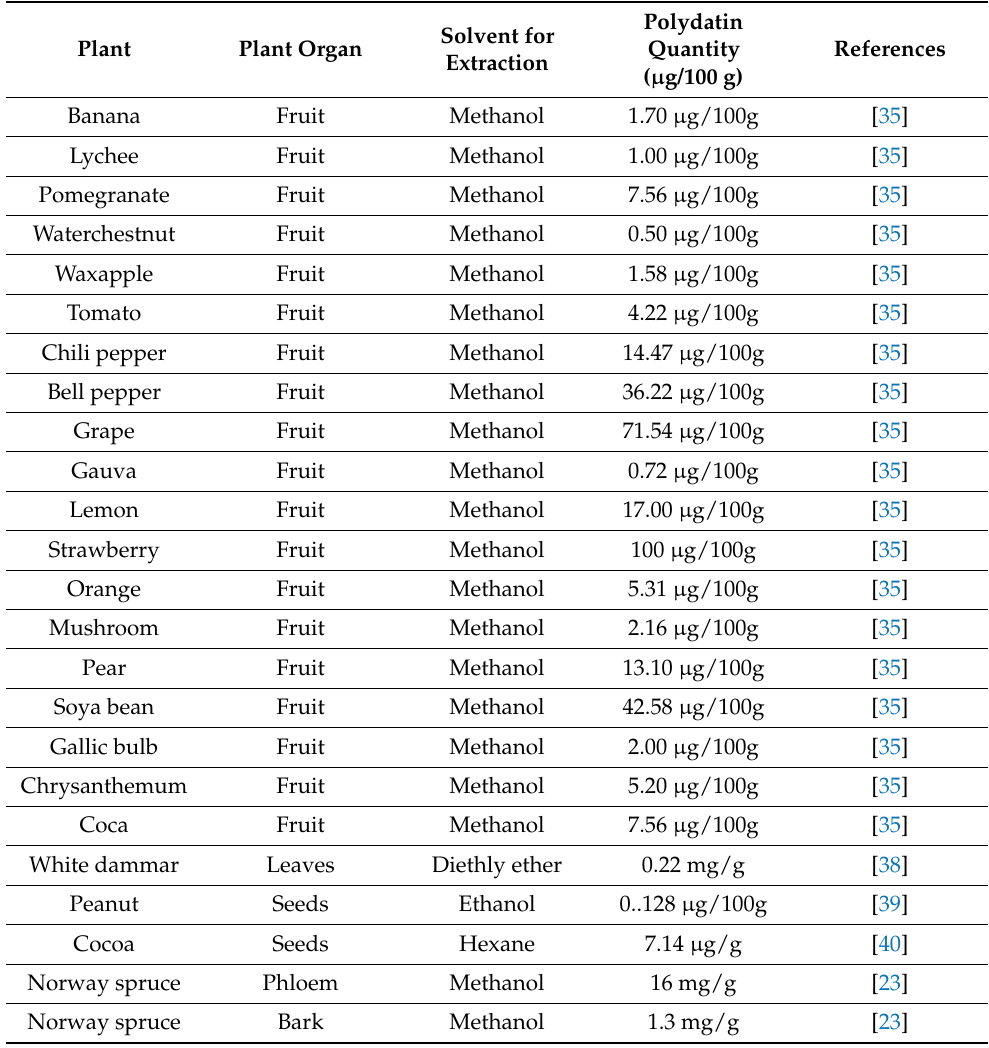
Table 1. Polydatin contents in vegetable and fruits